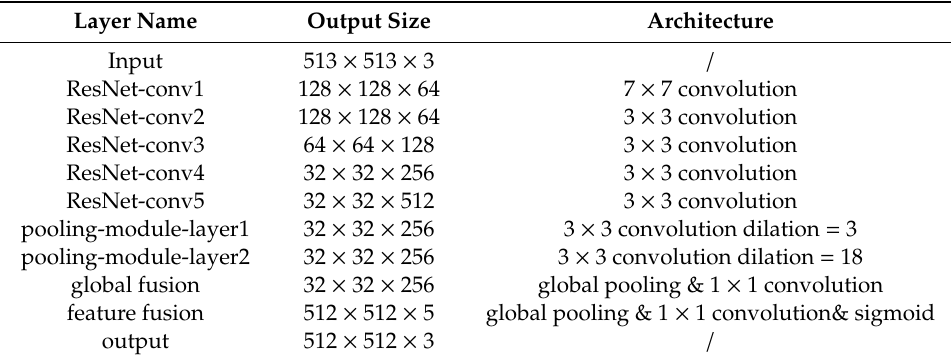
Table 2. Architecture of